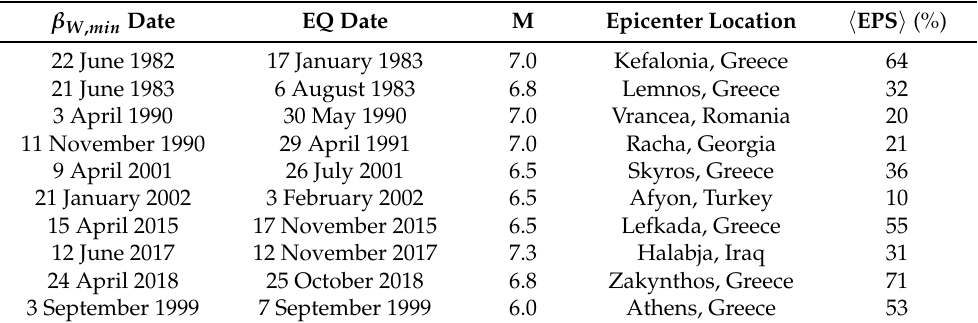
Table 2. The dates of minima observed in the limiting geographical areas of either the 5-core or the 6-core of the area N 50 E 46 that preceded the EQs with M ≥ 6.5, but were not simultaneous in both 25 5 areas. a On the last row, a local minimum that was also observed before the deadly Athens EQ was also added, see Figure 2. In the last column, we also inserted the (cid:104) EPS (cid:105) value at the grid point nearest to the epicenter when a 0.25 ◦ × 0.25 ◦ grid was used as in Figure